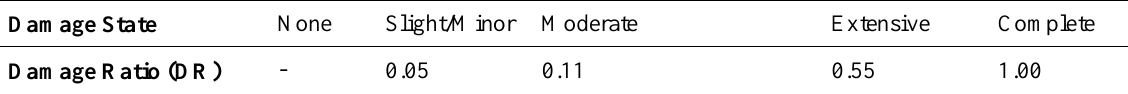
Table 12. Damage ratios for electric power substations